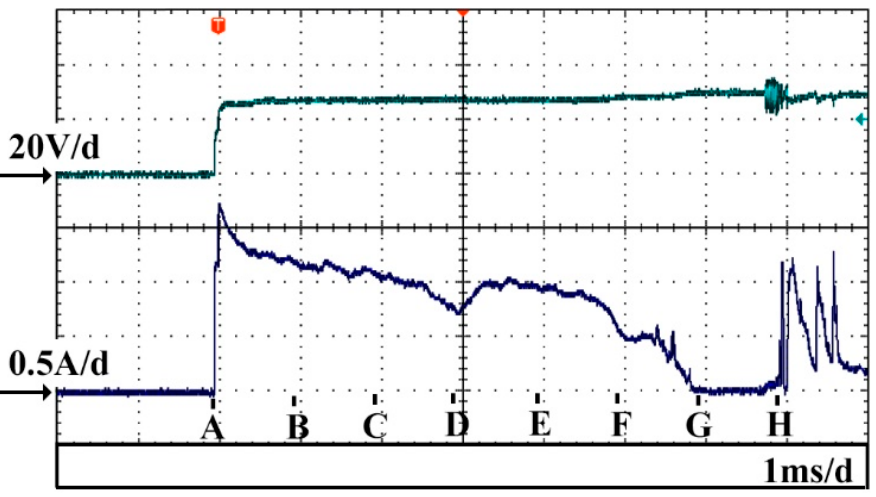
Figure 3. Temporal variations of voltage and current waveforms during gas film formation.